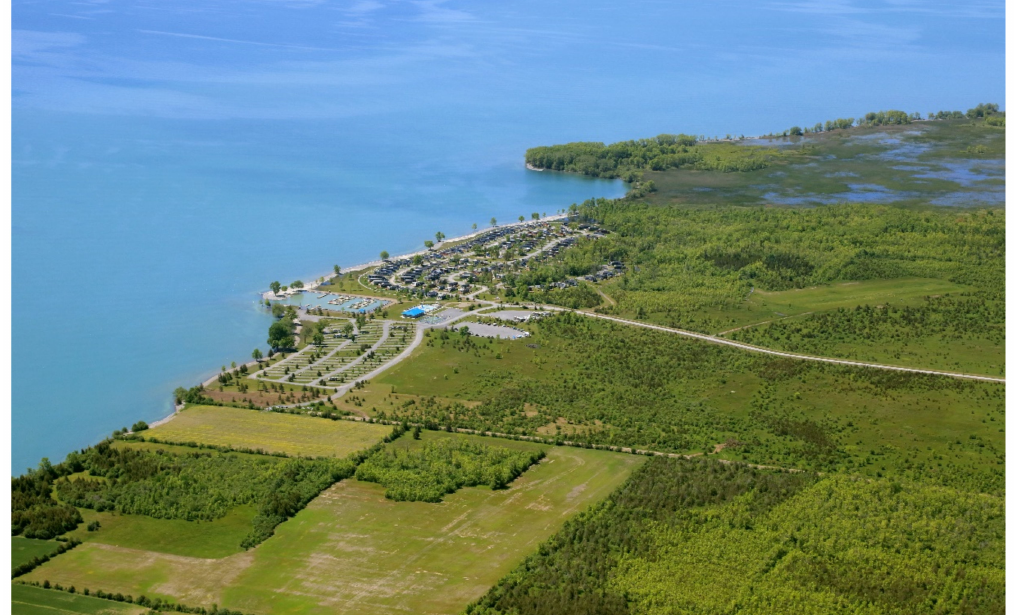
Figure 13. The high water level at Salmon Point—East Lake (Aerial image by: John A. Brebner, 2019 © 2019 Friends of Sandbanks Park).